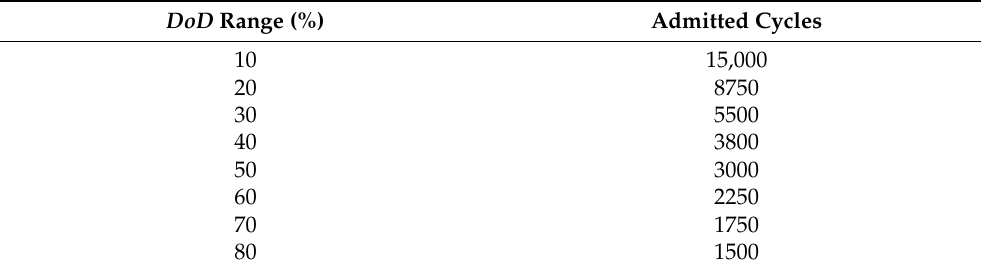
Table 2. DoD vs. maximum number of cycles at each DoD